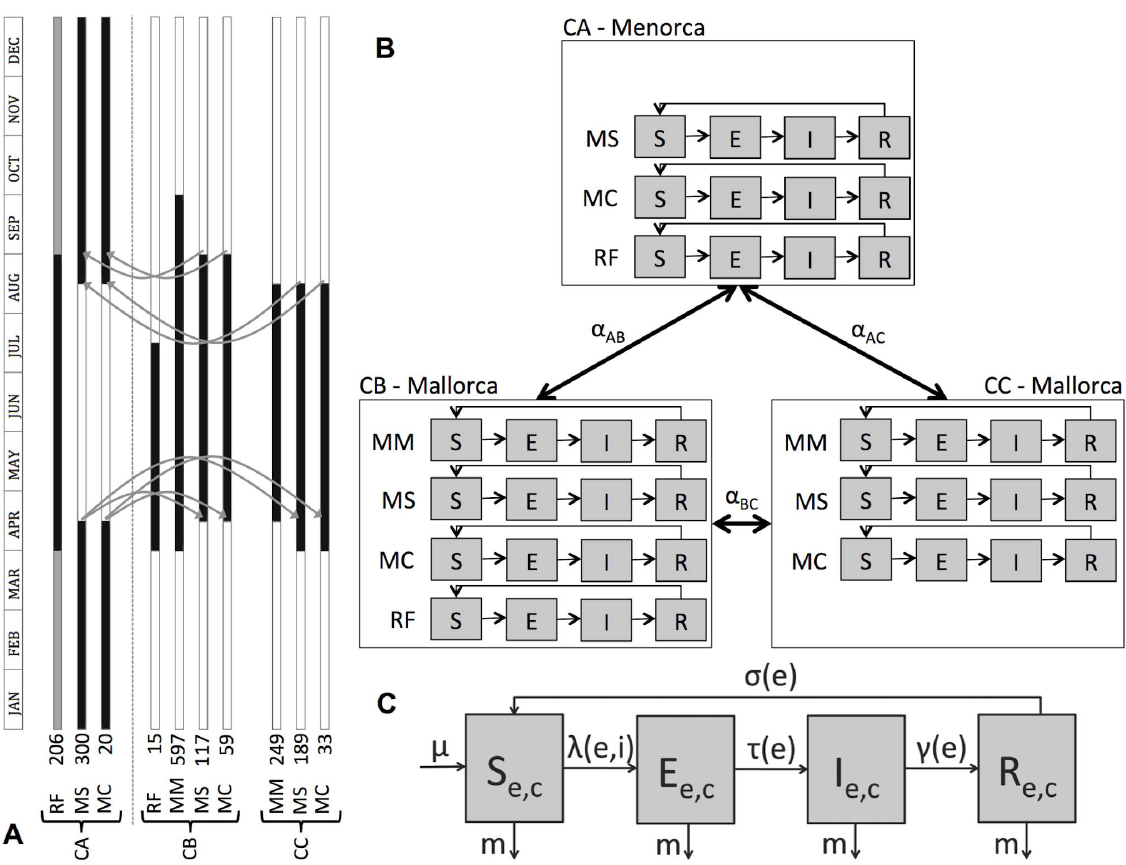
Figure 3. Model description. (A) January to December occupation of the caves by each species (black). The number of individuals of each subpopulation at the beginning of the simulations is indicated on the left. Gray periods represent only one-third of the colony remaining in the cave. Gray arrows indicate the seasonal interisland exchanges of individuals at certain times. Bat species names are abbreviated: MC, Myotis capaccinii ; MM, Myotis myotis ; MS, Miniopterus schreibersii and RF, Rhinolophus ferrumequinum . (B) Schematic representation of the metapopulation model, with three patches corresponding to the caves (CA, CB and CC) considered. Black arrows represent exchanges between caves. Each subpopulation is compartmentalized according to its infectious status: S (Susceptible), E (Exposed), I (Infectious) and R (Recovered). (C) SEIRS-model structure for EBLV- 1 2 infection dynamics in each subpopulation.